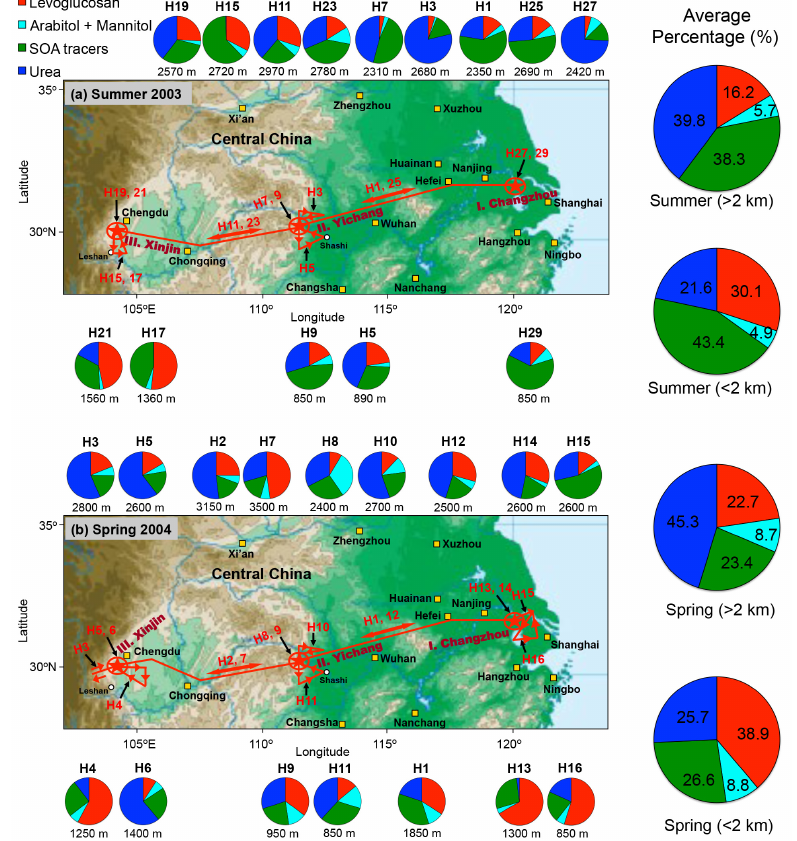
Fig. 10. Relative abundances (%) of POA and SOA tracers in the tropospheric aerosol particles (PM 10 ) over central China. The right-side pie charts with percentage values (%) show the averaged relative abundances for aerosol samples collected at relatively high (>2km) and low (<2km) altitudes in both